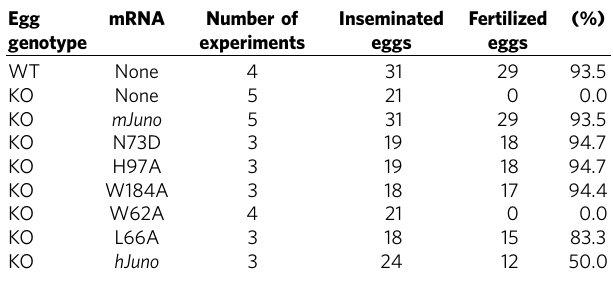
Table 2 | Fertilization rates in the sperm–egg fusion assay.